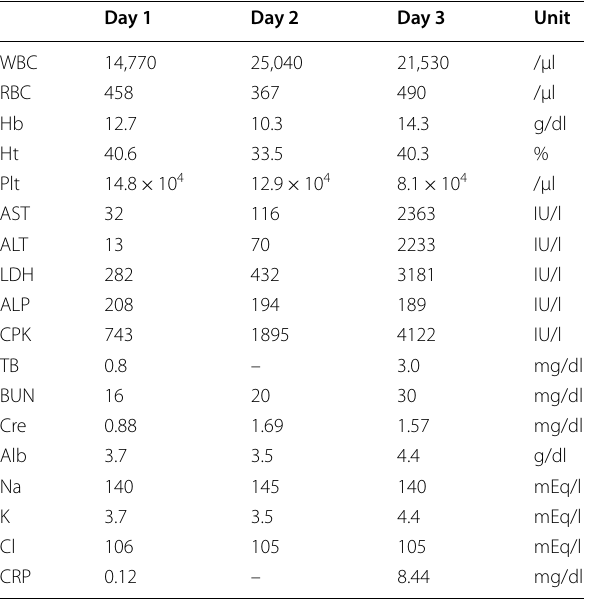
Table 1 Blood chemistry